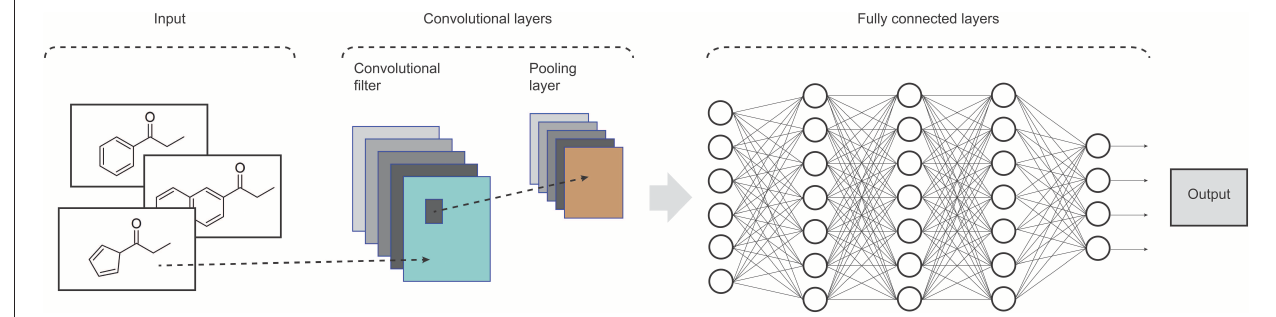
FIGURE 2 | Illustration of the structure of a standard CNN. In drug design, the input data could be molecular structures or atom distances from molecular graphs (adapted from Rawat and Wang,